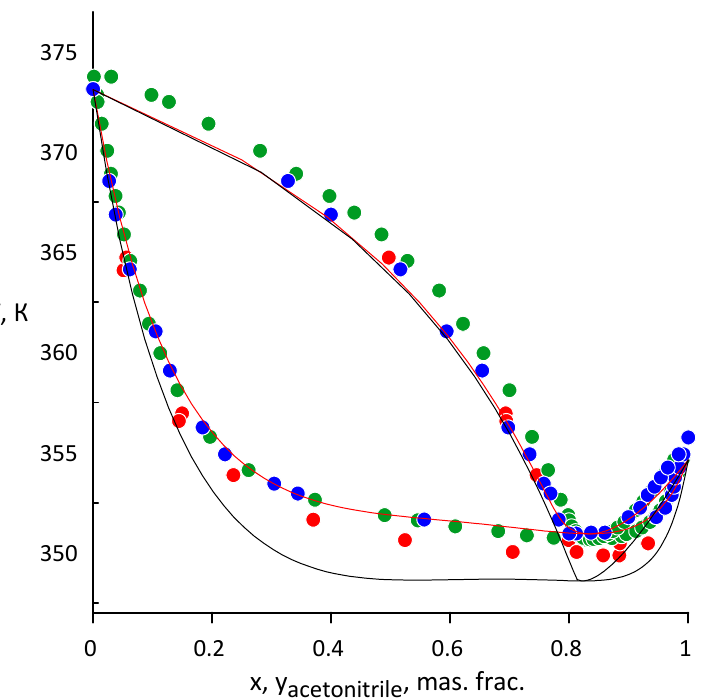
Figure 4. TXY diagram for a binary mixture of acetonitrile–water at atmospheric pressure. Green circles— [53], blue circles— [54], red circles—experimental data, red line—calculated by the UNIFAC model with corrected parameters black line—calculated by the UNIFAC model [55].